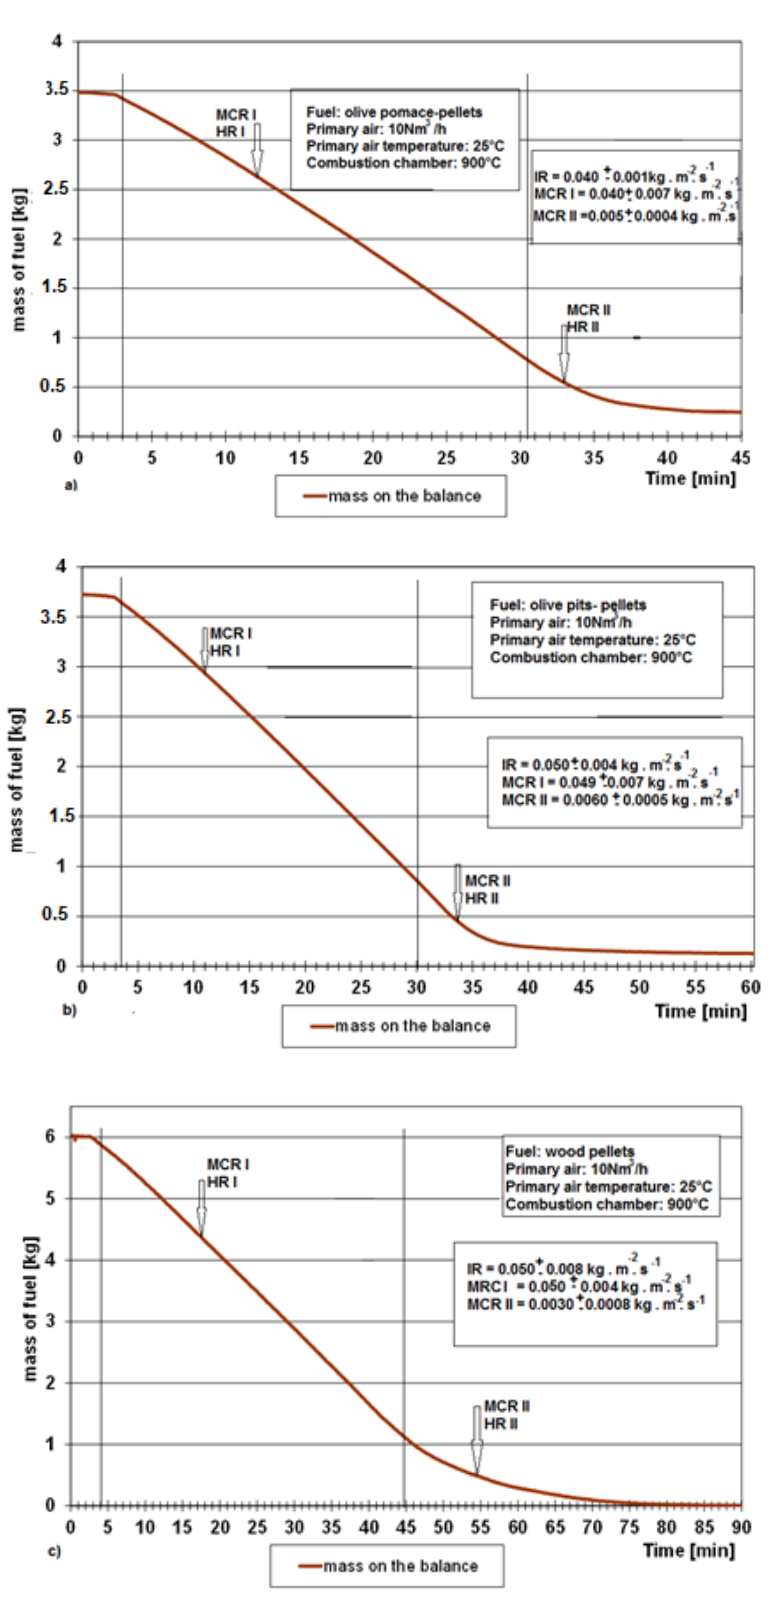
Figure 5. Mass loss curves in the fuel bed: ( a ) 100% OP; ( b ) 100% OP i ; ( c ) standard wood pellets. Experimental conditions: Primary air 10 Nm 3 /h; primary air temperature 25 °C, and combustion chamber temperature 900 °C.